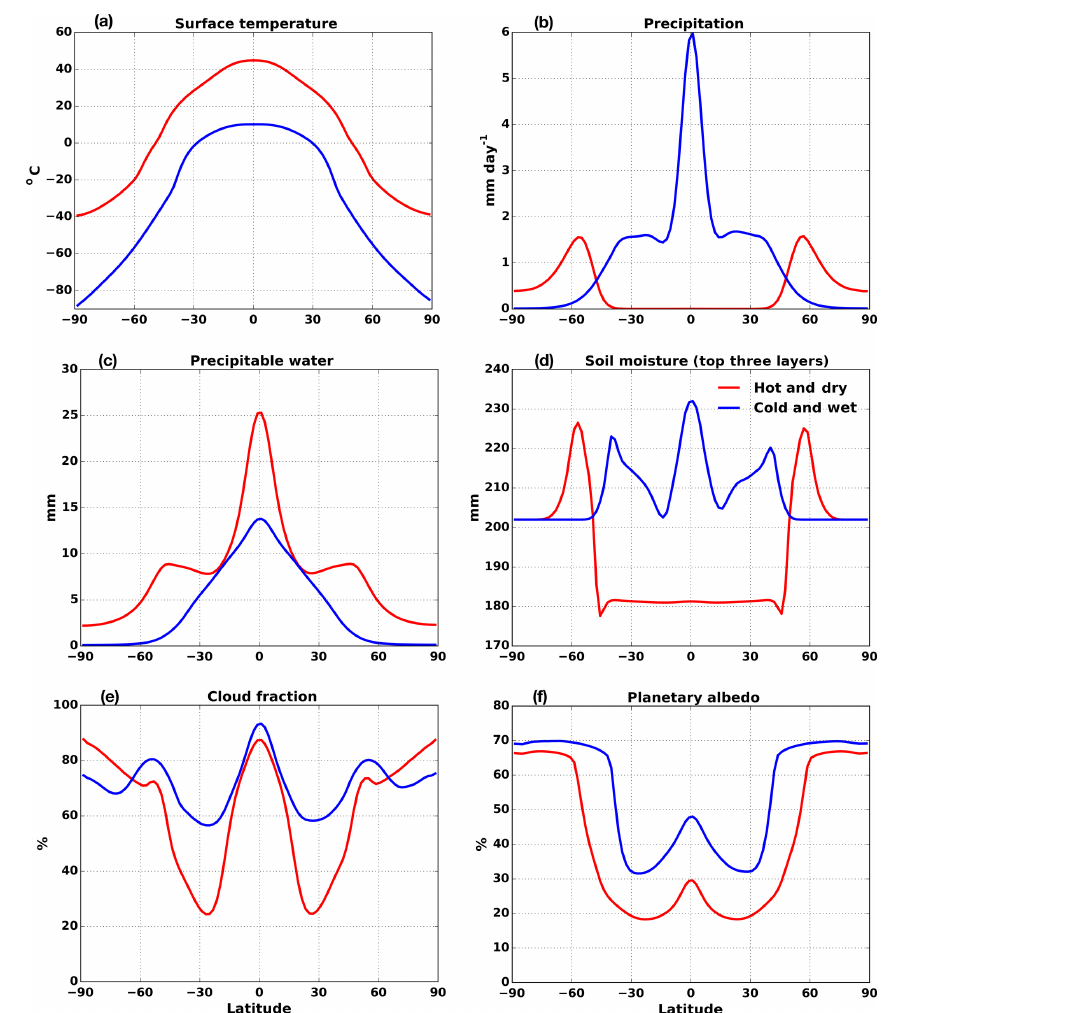
Figure 2. Annual mean meridional profiles of (a) surface temperature, (b) precipitation, (c) precipitable water, (d) soil moisture (averaged over the top three layers), (e) cloud fraction, and (f) planetary albedo for the two terra-planet states: HD ( α = 0.14) and CW ( α = 0.15) in the simulations Z14 and Z15 averaged over a period of 10